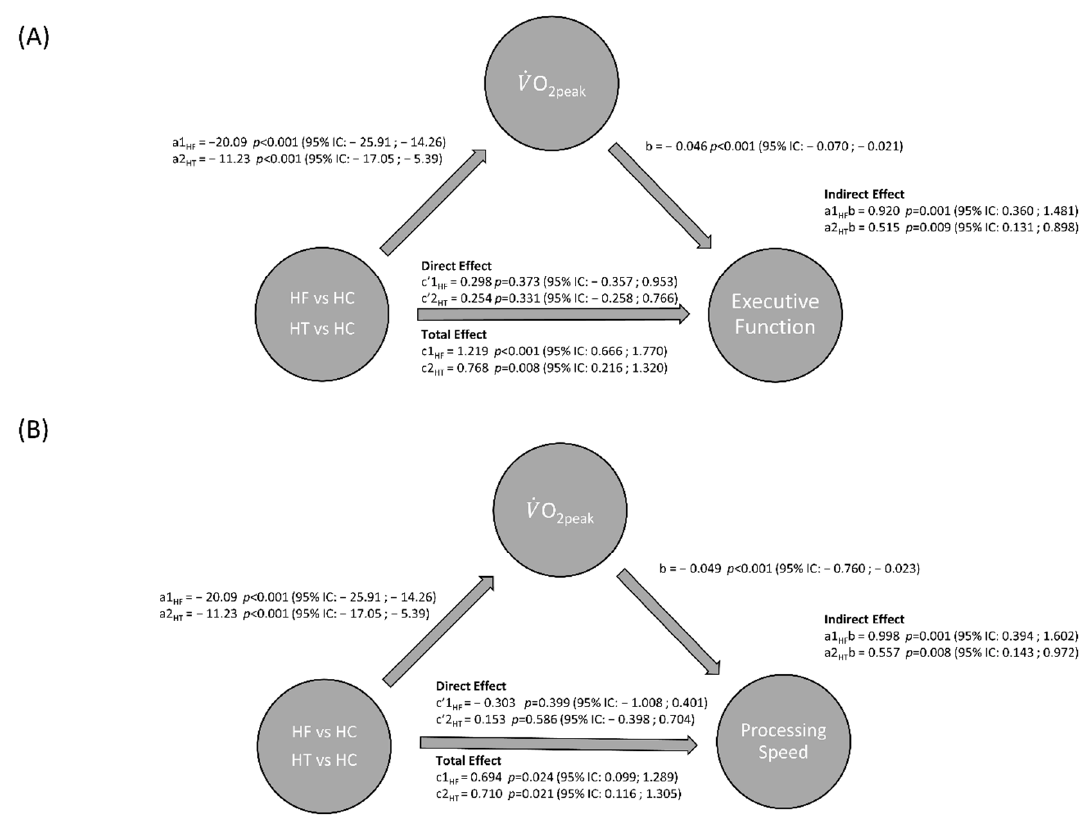
Figure 1. The mediating effect of cardiorespiratory fitness (V ̇ O 2peak ) on the relationship between group and executive function ( A ) and processing speed ( B ). The categorical variable group has three levels: healthy controls are coded as 0, heart failure as 1 and heart transplant as 2. The healthy control group is the reference group. a n path is the effect of group on 𝑉(cid:4662) O 2peak and b path is the effect of 𝑉(cid:4662) O 2peak on executive functioning. c n is the total effect of group on executive functioning and c’ n is the direct effect of group on executive functioning.